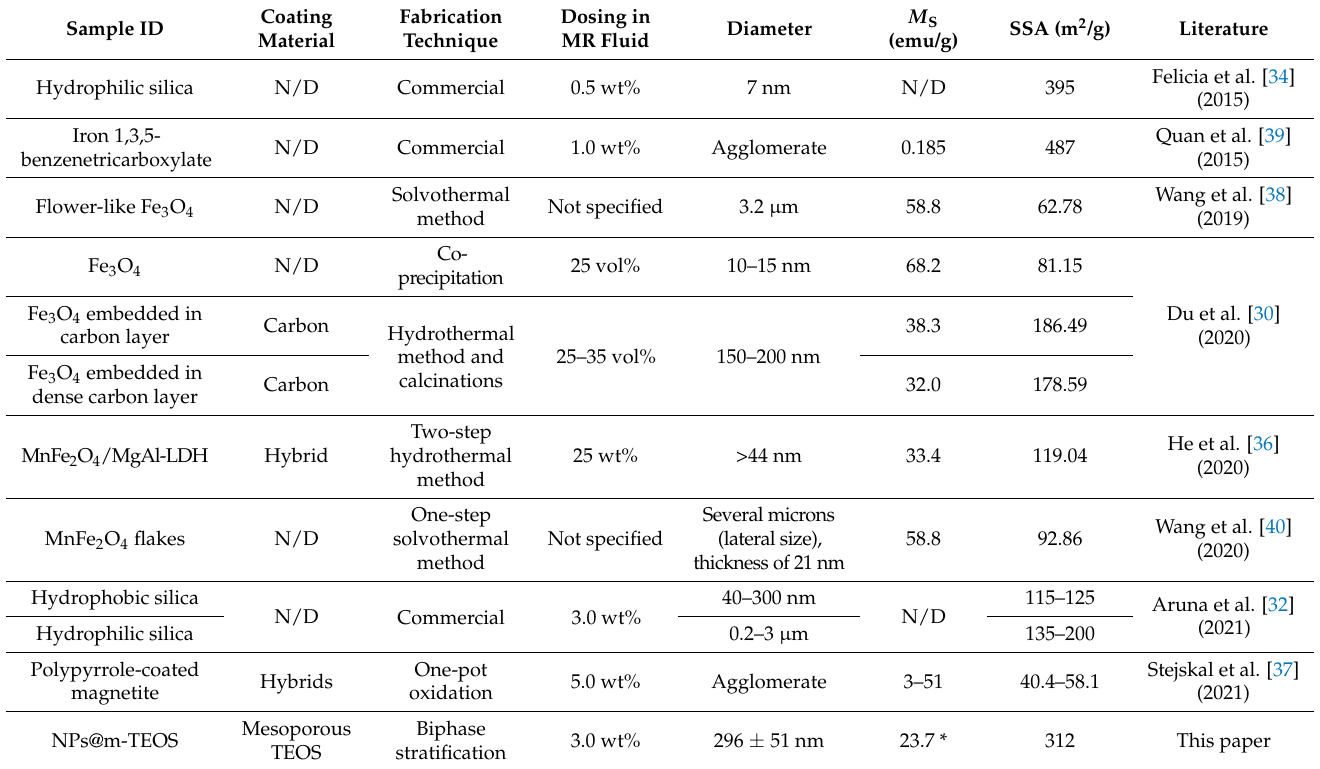
Table 1. Overview of nano-fillers and related SSA values, as documented in recent research on MR